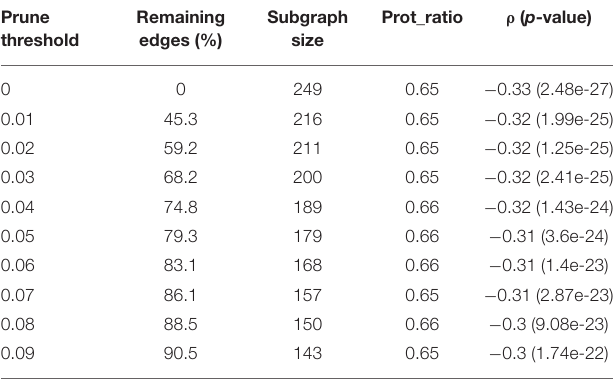
TABLE 3 | Threshold pruning on the subgraph created by seed = 248.